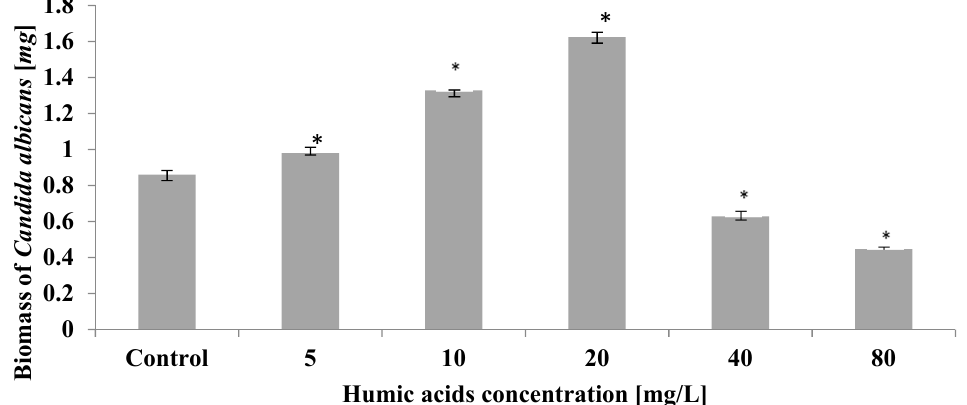
Figure 1. The effect of humic acids on biomass of Candida albicans on the 5th day of culture ( n = 8, average values ± SD, ( p ≤ 0.01), (*) shows statistically significantly different values in comparison with control sample.